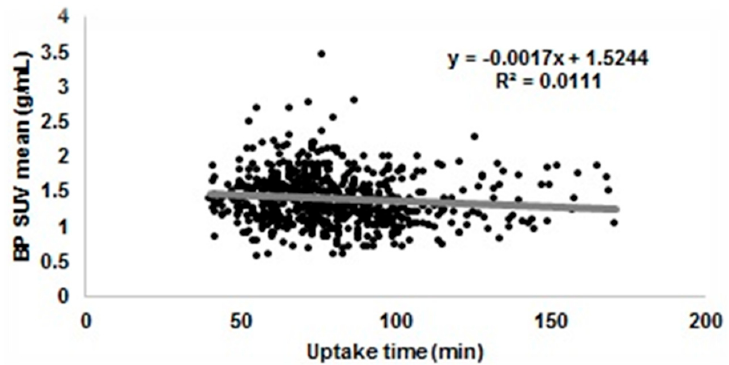
Figure 6. SUV of the blood pool as a function of uptake time in 1132 PET scans acquired from over 56 PET sites across the world. SUV of the blood pool is the mean SUV of a 1 cm diameter circle positioned in the descending aorta. The average SUV is 1.40 ± 0.38 min (range 0.40–3.45).